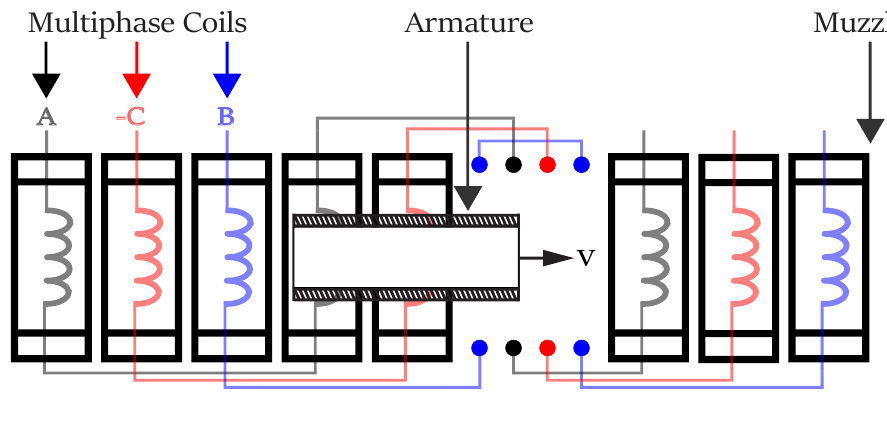
Figure 1. The structure of an asynchronous